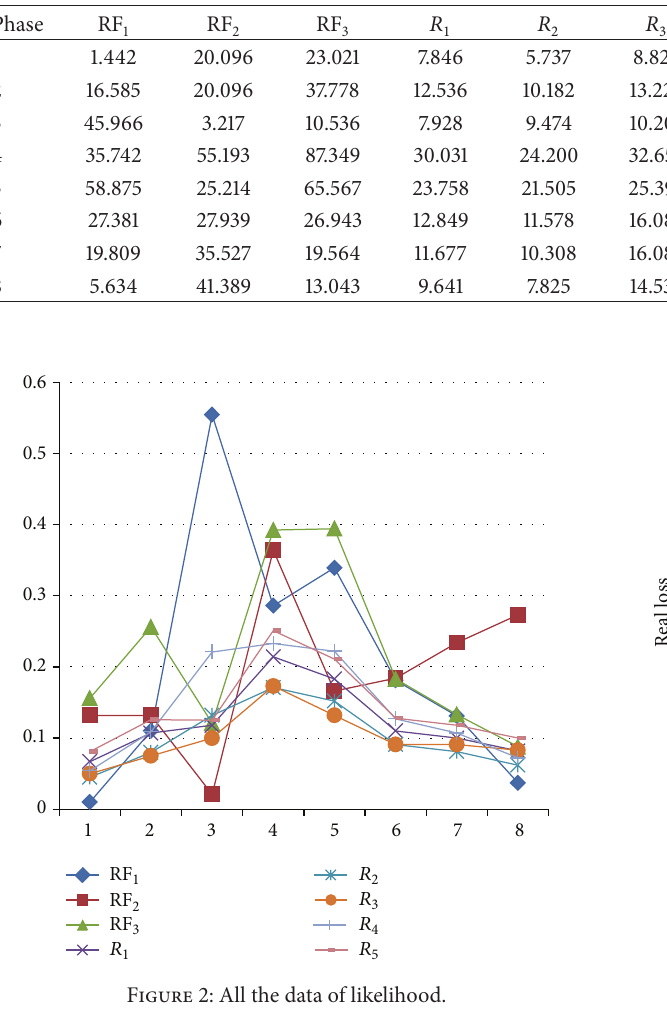
Table 2: Actual loss of risk factor, risk, and risk consequence in each phase (unit: 1,000USD).